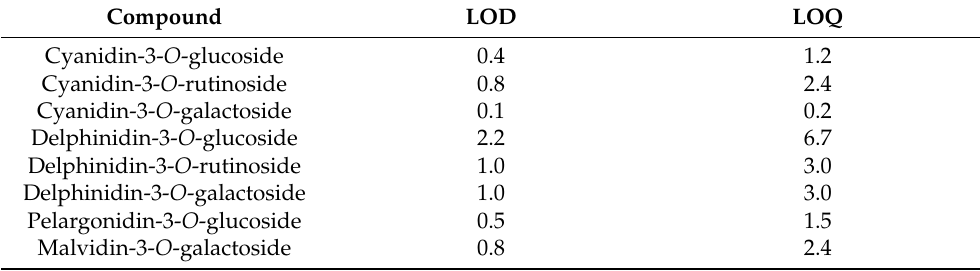
Table 1. LOD and LOQ values for all anthocyanins used in the presented experiment (mg/100 g f.w.). Compound